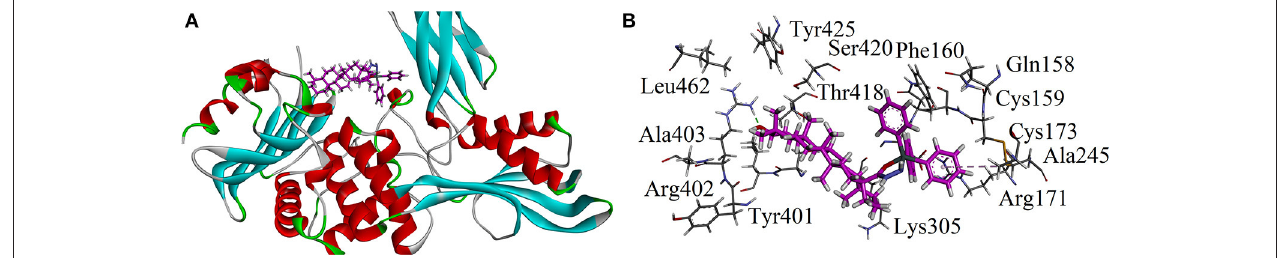
FIGURE 11 | (A) The three dimensional (3D) of triphenyl tin complex (LTP) into the binding site of 2EX9; (B) Close-up depiction of docking pose of LTP showing